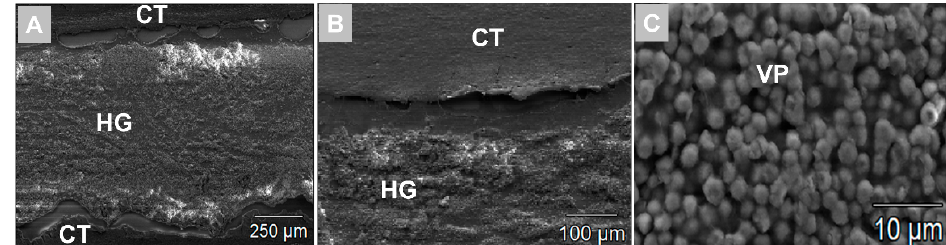
Figure 5. Exemplary SEM images from the VH-B group at day 30 post implantation. ( A ) Vaterite- loaded hydrogel (HG) within the subcutaneous connective tissue (CT) (magnification = 200 × , scalebar = 250 µ m). ( B ) Image from the hydrogel (HG)–tissue interface (magnification = 500 × , scalebar = 100 µm). ( C ) Vaterite particles (VP) within the hydrogel region (magnification = 5000 × , scalebar = 10 µm).